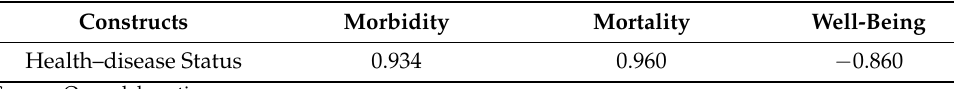
Table 5. Individual item reliability